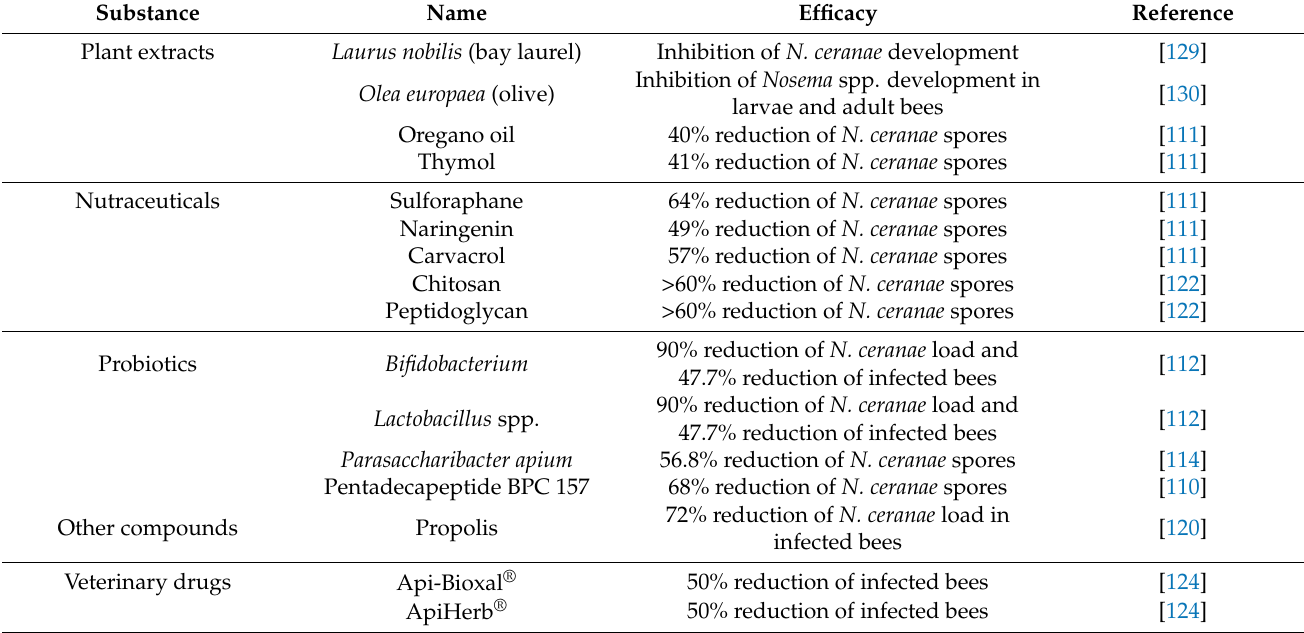
Table 1. Efficacy of alternative treatments against N. ceranae